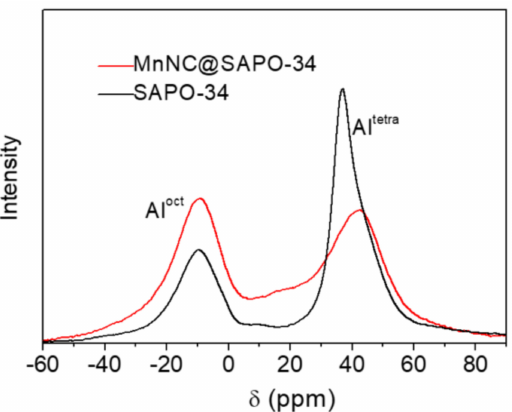
Figure 5. Solid-state 27 Al NMR spectra of SAPO-34 and MnNC@SAPO-34 catalyst. The 27 Al NMR peaks at 36.9 and 44.2 ppm are attributed to tetrahedrally coordinated Al (framework Al, noted as Al tetra ), and other peaks at -9.8 and -9.4 ppm are assigned to octahedrally coordinated Al (extraframe- work Al, Al oct ).